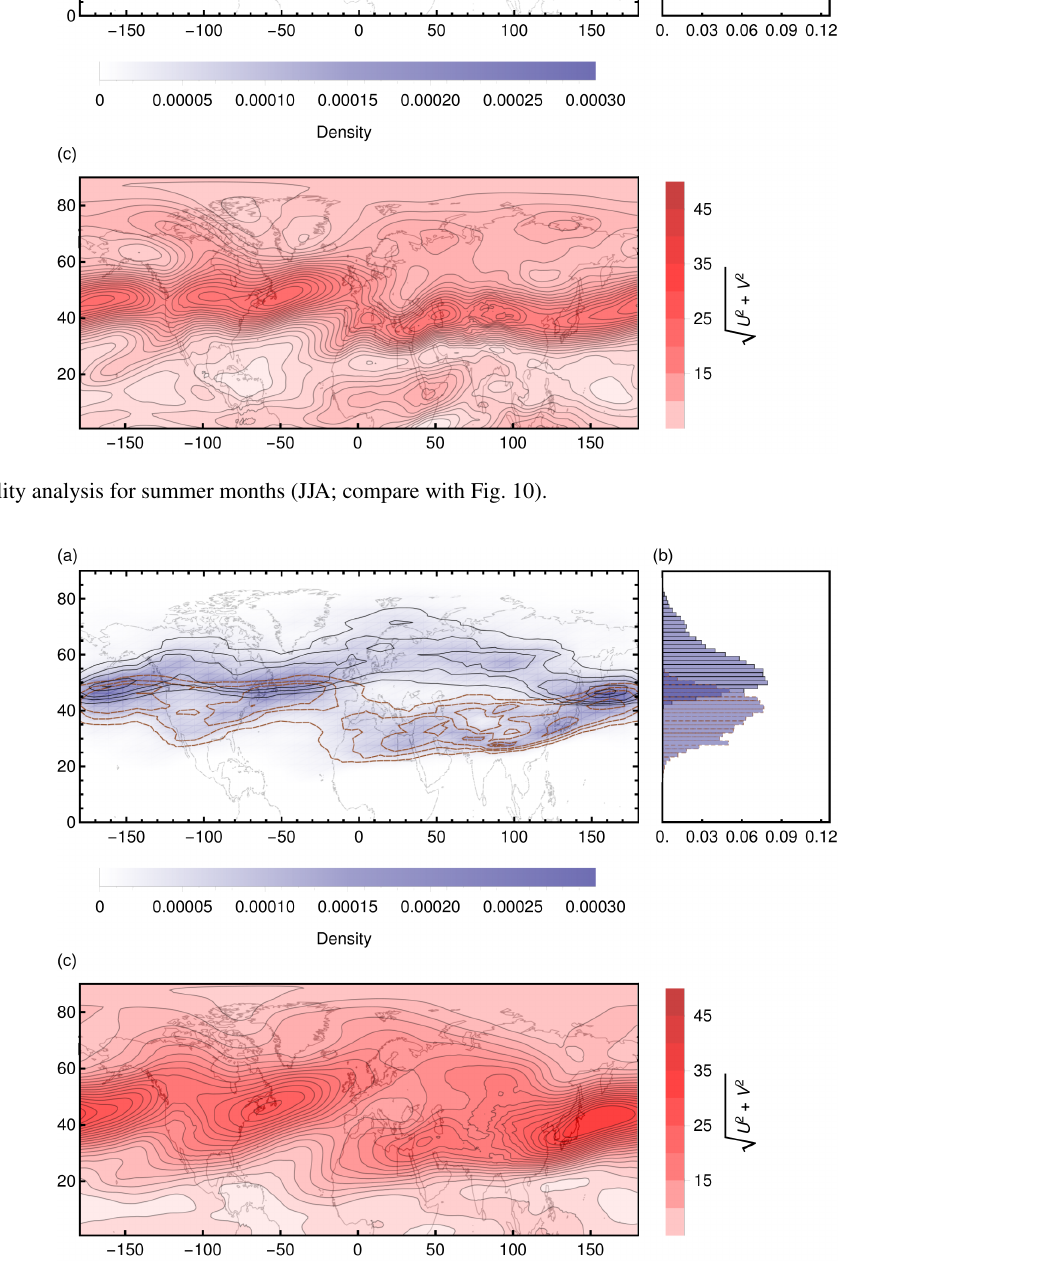
Figure 12. Probability analysis for autumn months (SON; compare with Fig.